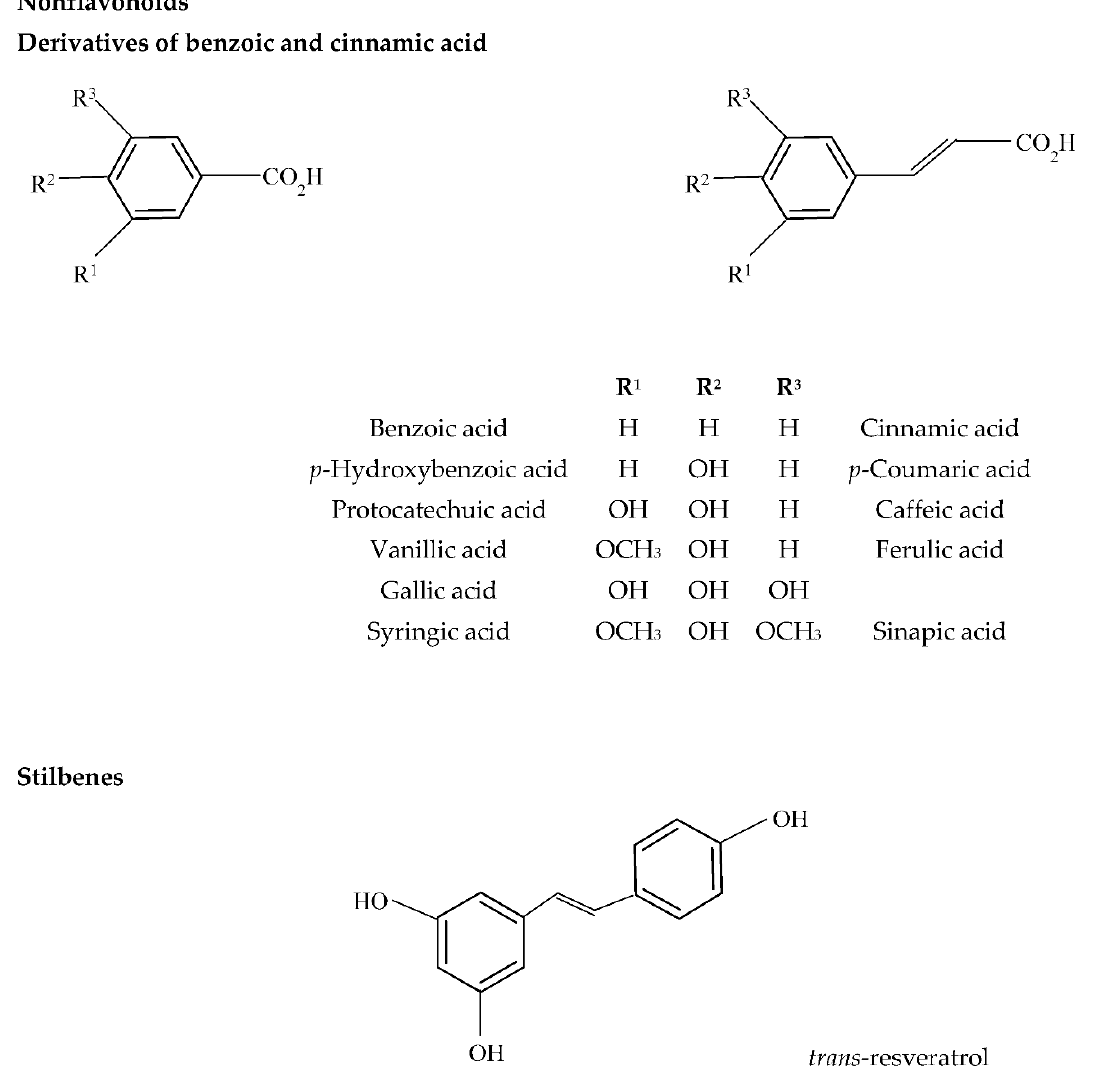
Figure 3. Chemical structures of the most important nonflavonoids participating in enzymatic oxidation in wine.